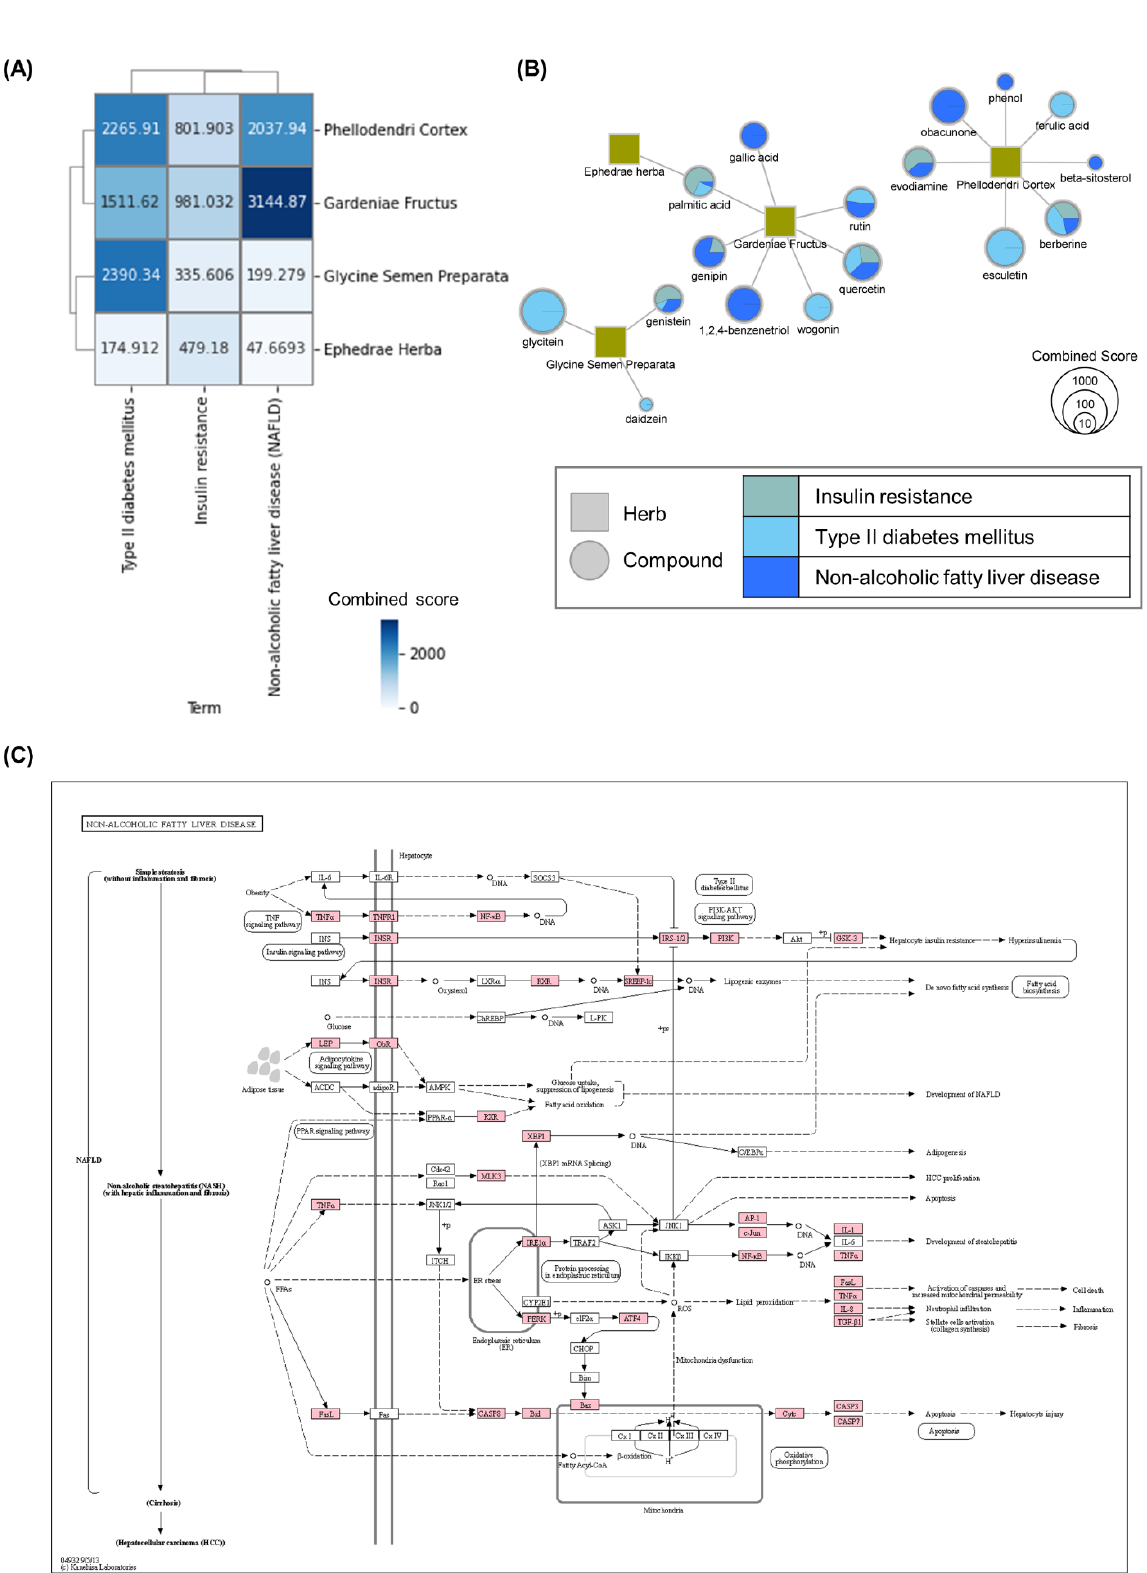
represent proteins that compose the pathway. The pink-colored boxes represent predicted targets of AMGB. All the details are the same as in Figure 1.